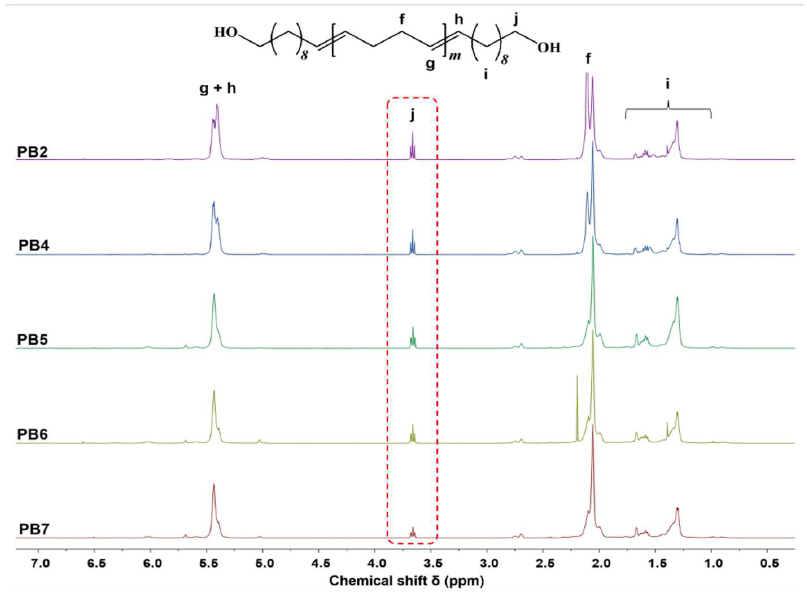
Figure 6. 1 H-NMR spectra (400 MHz, CDCl 3 , TMS) of catalyst optimization used for the synthesis of biobased HTPB.